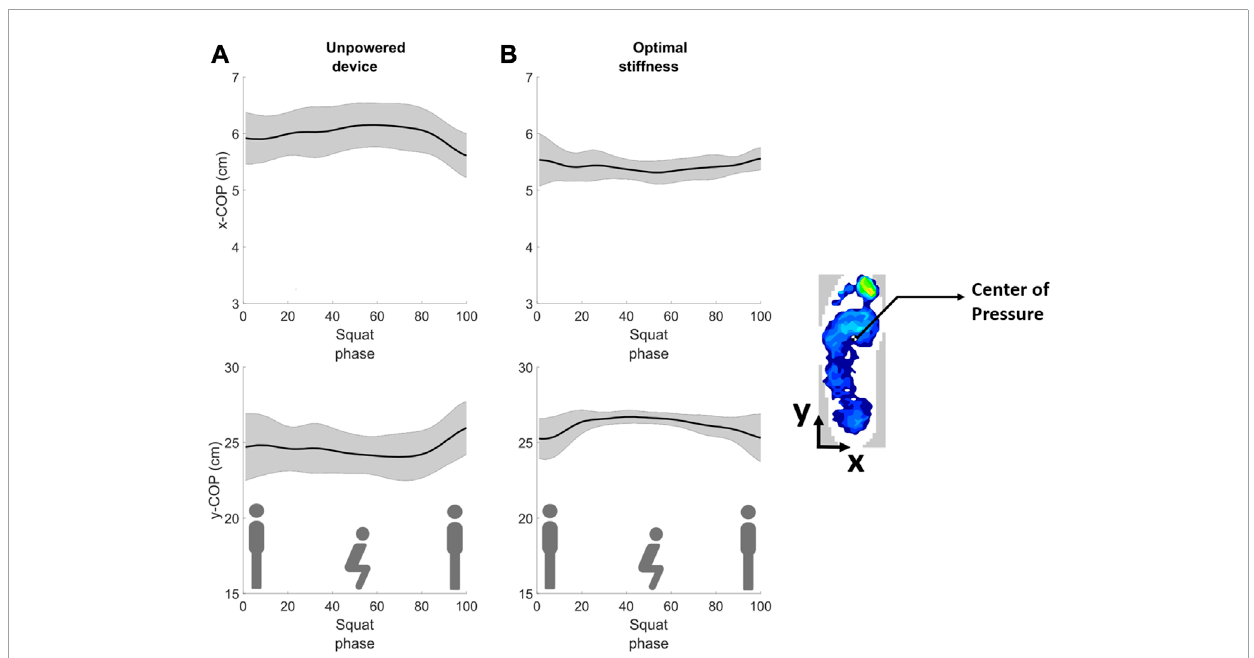
FIGURE 1 The foot Center of Pressure trajectories (in the medial-lateral direction (xCoP) and anterior-posterior direction (yCoP) for a representative subject while squatting with the device in (A) unpowered and (B) optimal assistance conditions. The CoP trajectories are shown with the variability (standard deviation) after time synchronous